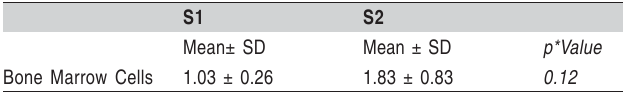
Table 1 - Cell adhesion to polished (S1) and cathodic cage plasma nitrided (S2) Ti